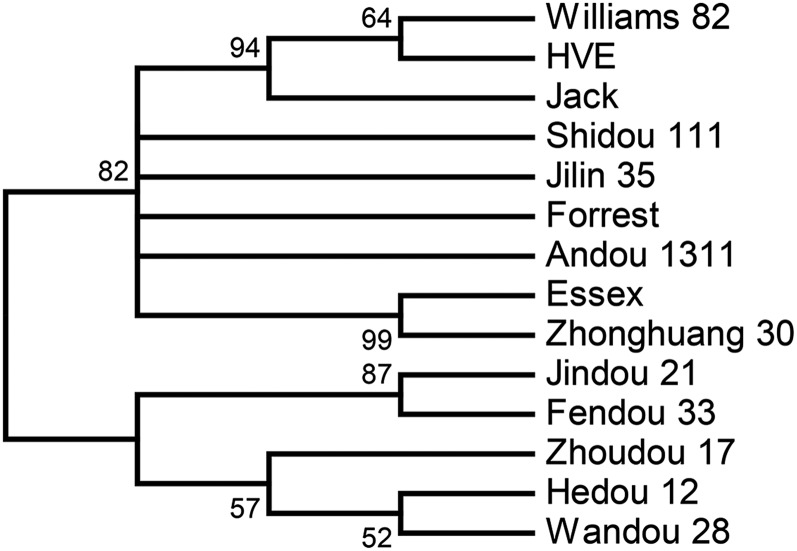
Dendrogram of unweighted pair group method analysis (UPGMA) clustering analysis of 14 soybean cultivars.